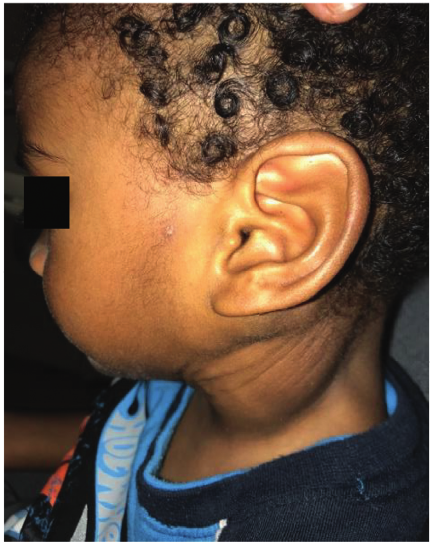
Figure 9: Cystic hygroma 9 months after